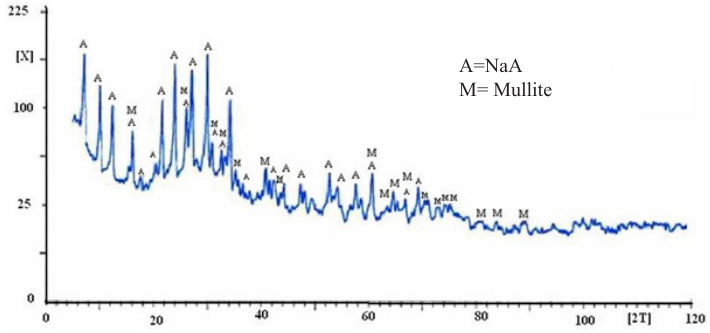
Fig. 5. XRD pattern of the zeolite NaA membrane with 2 times synthesis